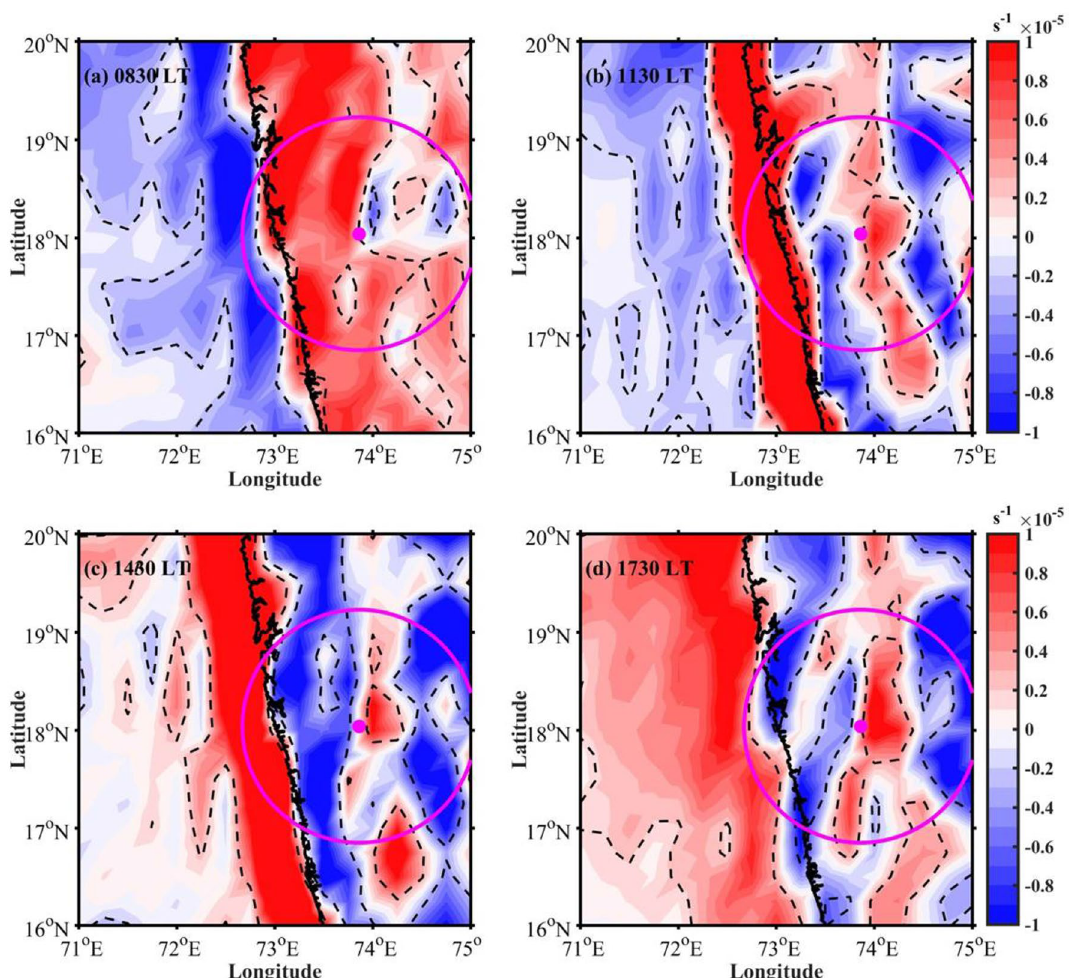
Figure 6. Spatial distribution of mean removed divergence at ( a ) 0830 LT, ( b ) 1130 LT, ( c ) 1430 LT, and ( d ) 1730 LT. The data significant above 90 % confidence level are shown with dashed contours.